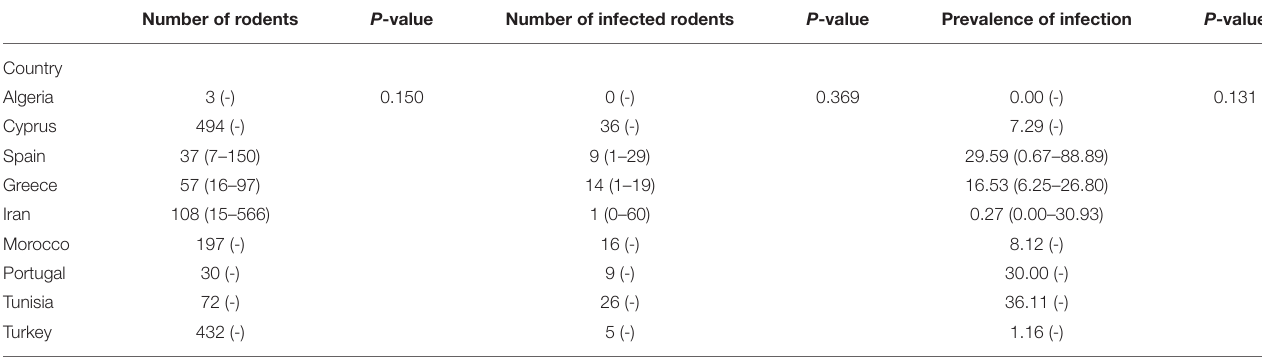
TABLE 1 | Median (rank) of studied rodents and the prevalence of infection in each country. Number of rodents